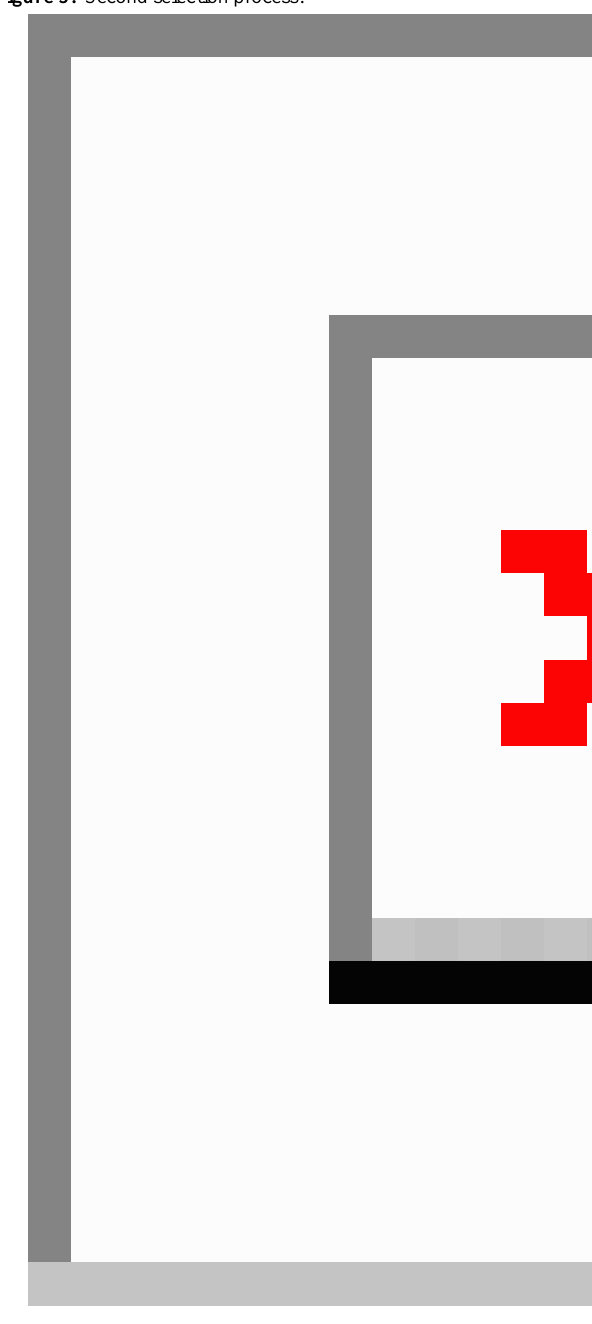
Figure 3. Second selection